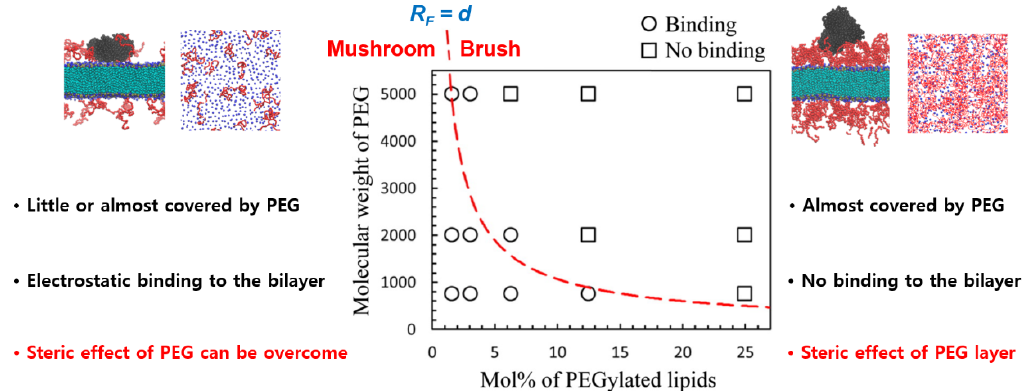
Figure 7. Characterization of binding (circles) and no-binding (squares) between plasma protein (human serum albumin) and the surface of PEGylated bilayer as functions of PEG size and grafting density. The boundary between mushroom and brush states is represented as a thick red line, where the Flory radius equals the distance between the grafting points of PEG (reprinted with permission from [168] . Copyright (2016) American Chemical Society).